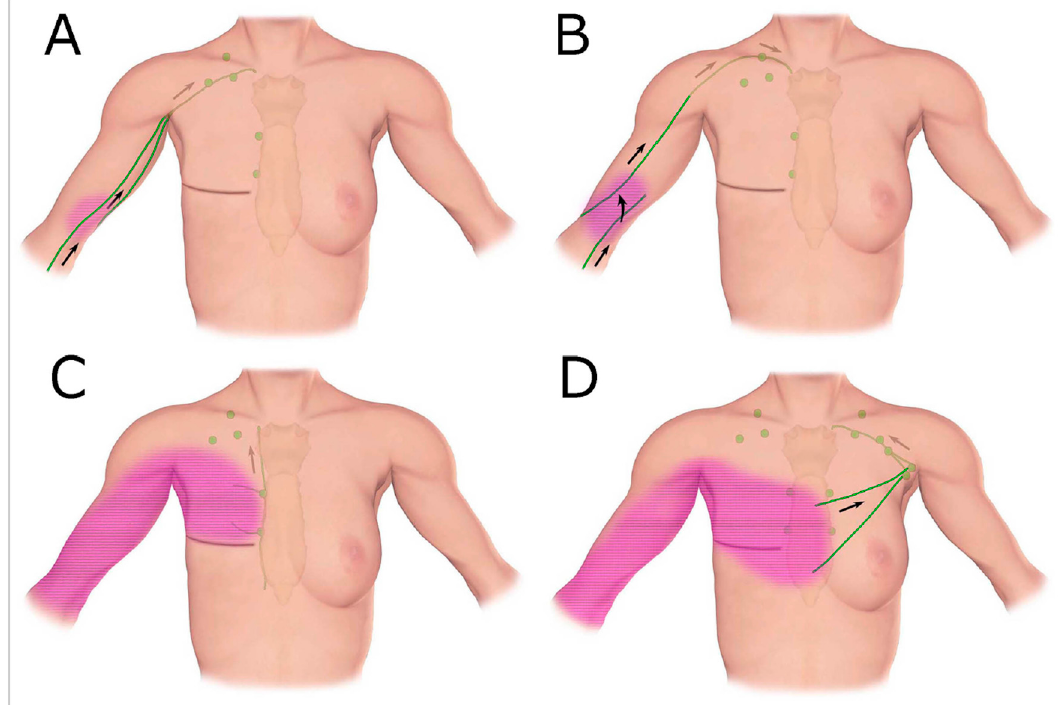
Figure 7. Schematic diagrams show patterns of lymphatic drainage in upper extremity lymphoedema. ( A ) The ipsilateral axillary region, ( B ) the clavicular region, ( C ) the parasternal region, ( D ) The contralateral axillary region. (Reproduced from [42] with permission.).